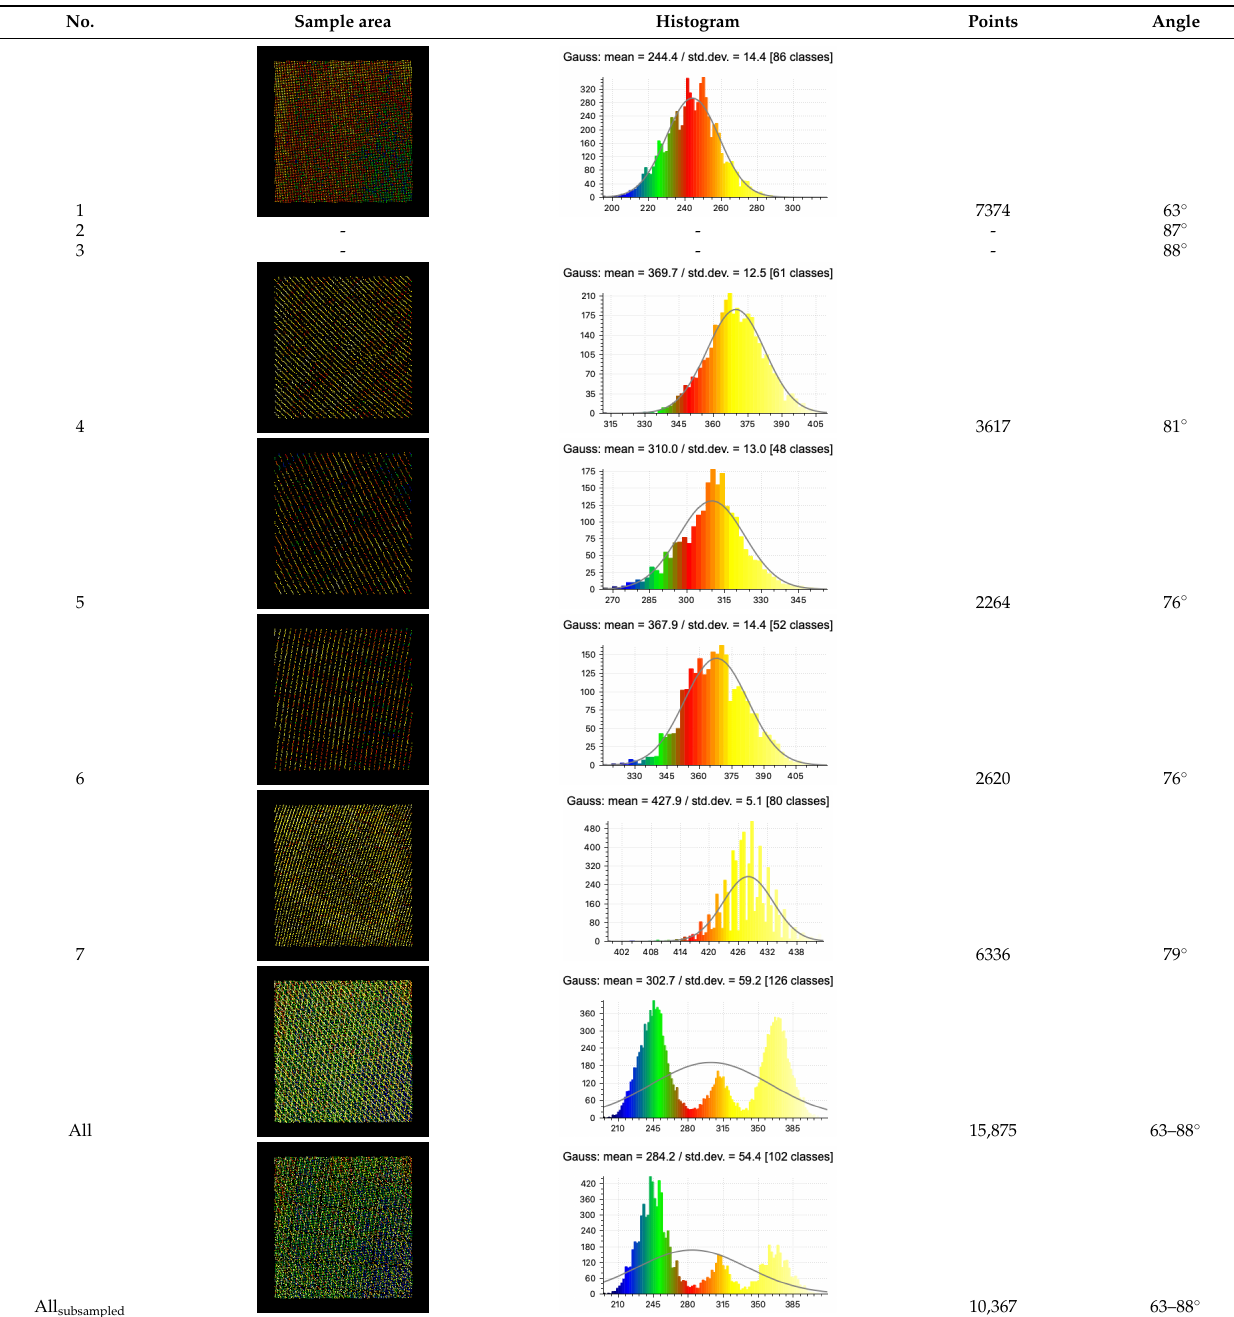
Table A5. The horizontal sample area: included scans (single scan stations “1–7”, merged scans “All”, and merged scan subsampled with octree level 12), sample area visualization, histogram of luminances, the number of points, and the angle between the surface normal and the measurement direction. Scans 2 and 3 were left with no observations due to the large measurement angle. Scan number 7 was partly overexposed and therefore omitted from the merged clouds.